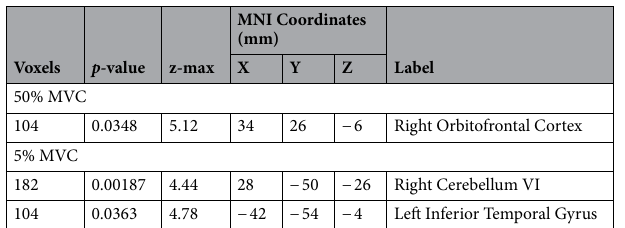
Table 1. Post > pre-force-matching task rs-fMRI contrasts from iM1 seed-based functional connectivity analysis.